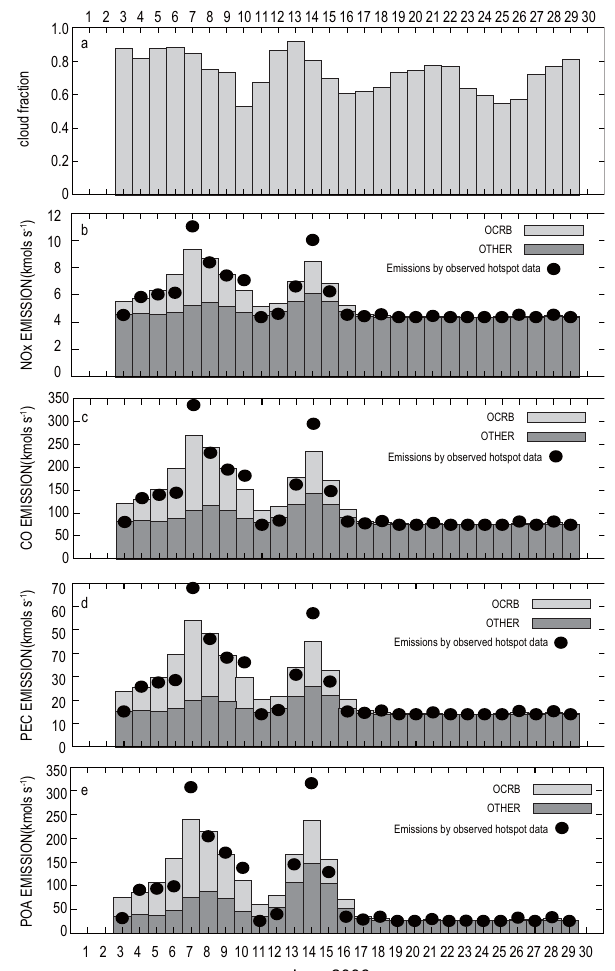
Fig. 3. Daily cloud fractions over East China (20–40 ◦ N, 100– 125 ◦ E,) and emissions over CEC (30–40 ◦ N, 111–120 ◦ E). (a) Cloud fractions. The analyses used in this figure were produced with the Giovanni online data system, developed and maintained by the NASA GES DISC (Acker and Leptoukh, 2007). The daily (b) NO x , (c) CO, (d) PEC and (e) POC emissions were divided us- ing the smoothed (bars) and observed hotspot data (dots). OCRB is emissions from open crop residual burning. OTHER is emission from sources other than OCRB.